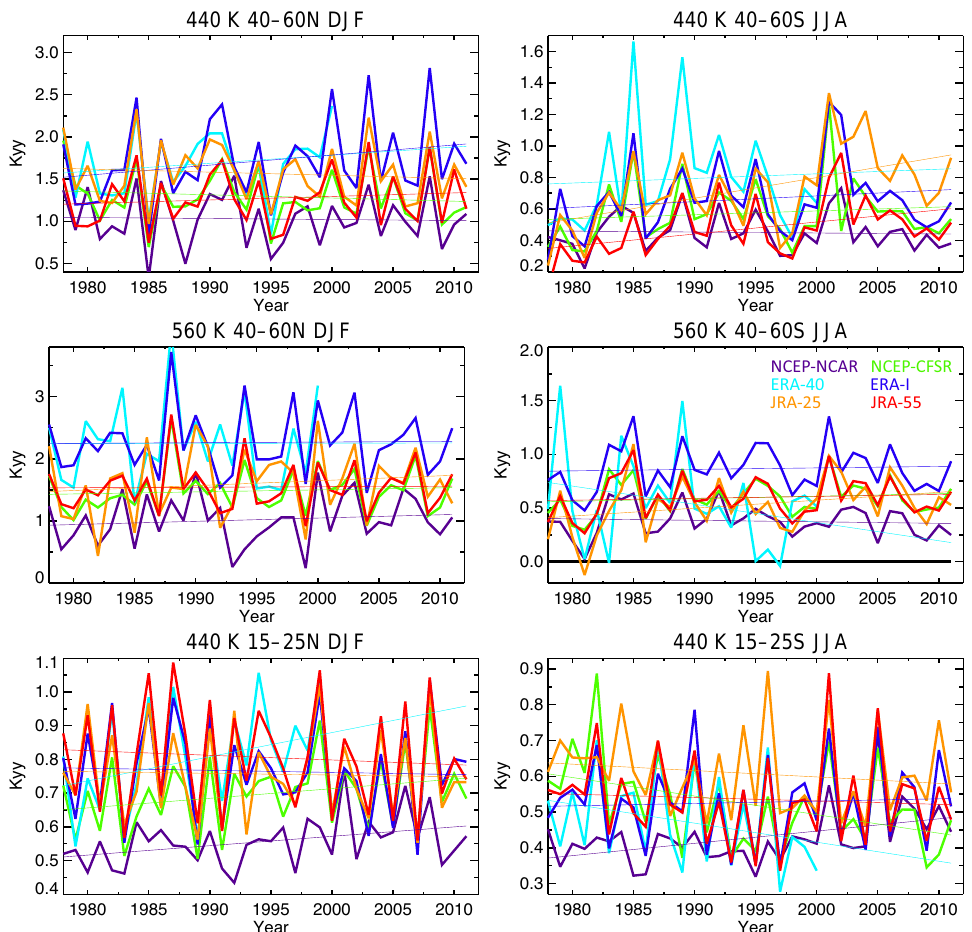
Figure 2. Temporal variations of the isentropic diffusion coefficient Kyy ( l = 1 month) (in 10 6 m 2 s − 1 ) averaged over 40–60 ◦ N in DJF (left) and 40–60 ◦ S in JJA (right) at 440K (top) and 560K (bottom) for 1978–2012. The linear trend slope is also shown for each data set. The results are shown for the NCEP-NCAR reanalysis (purple), NCEP-CFSR (green), ERA-40 (light blue), ERA-Interim (blue), JRA-25 (orange), and JRA-55